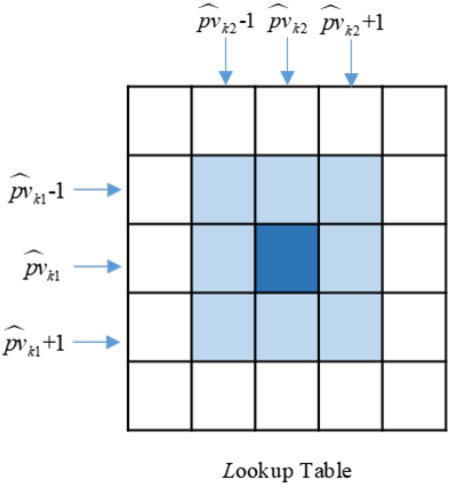
Figure 5. Fuzzy search strategy.